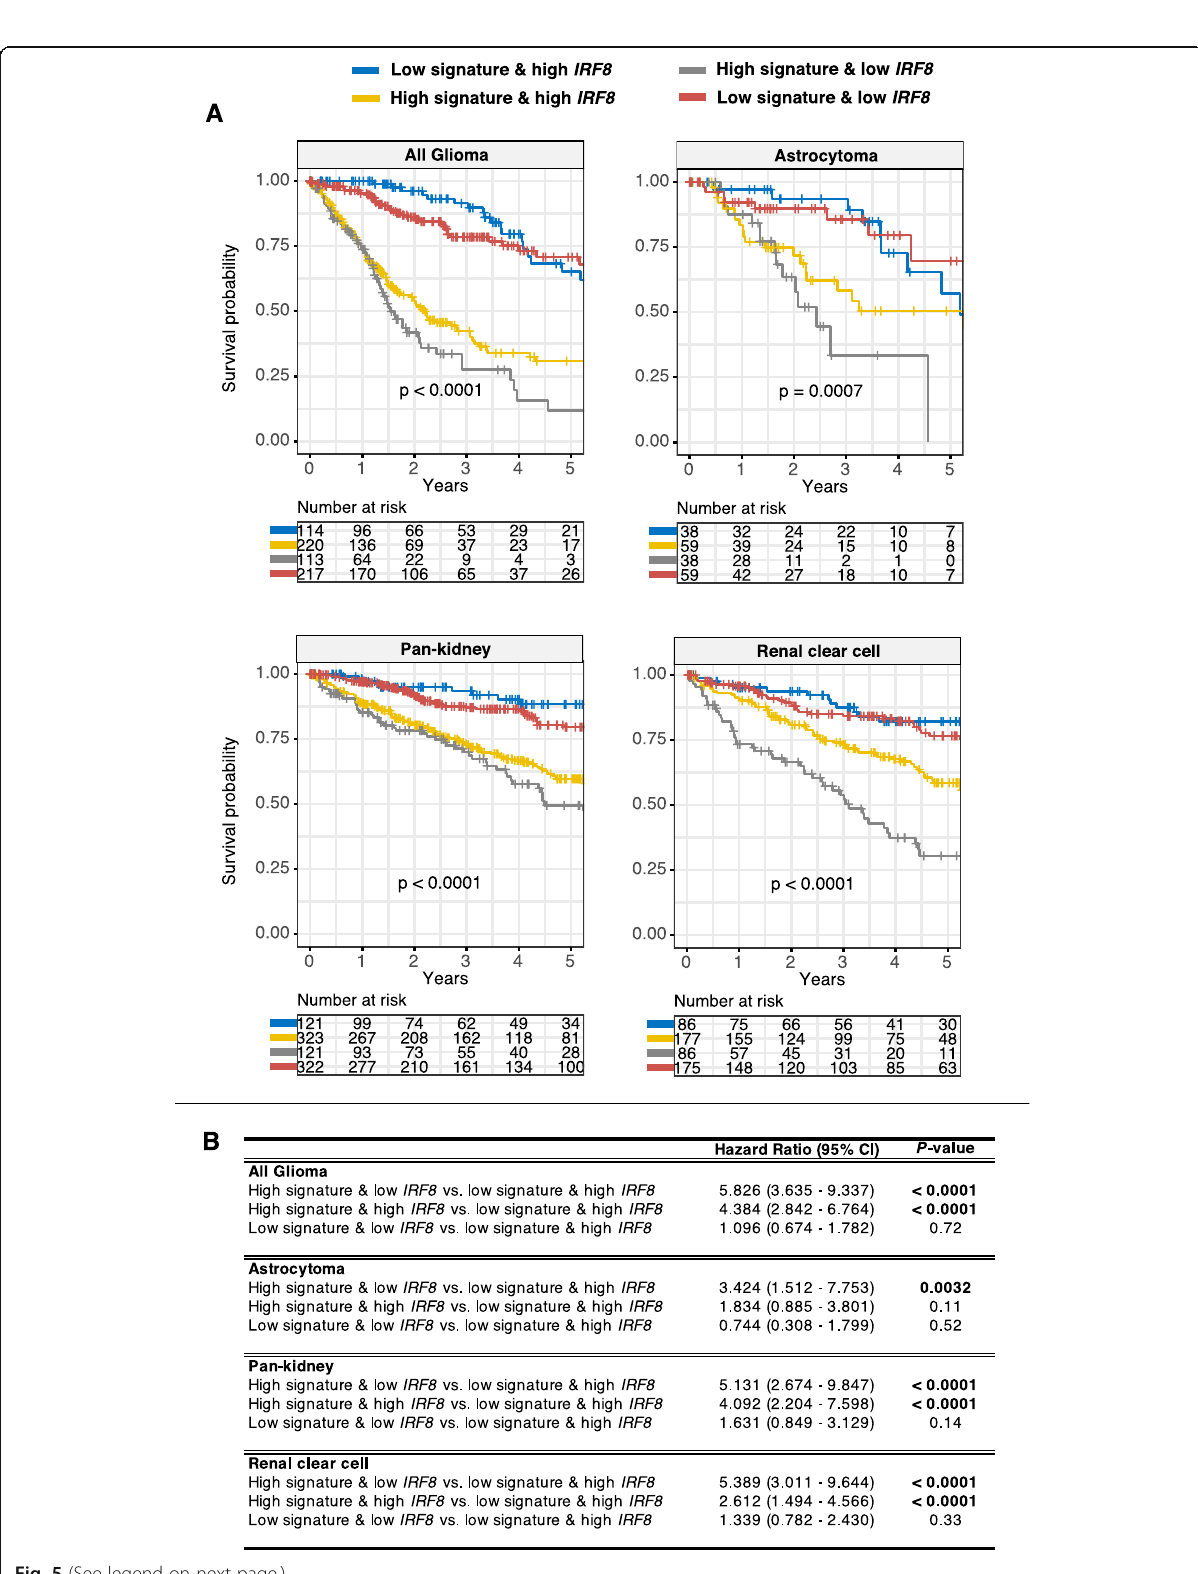
Fig. 5 (See legend on next